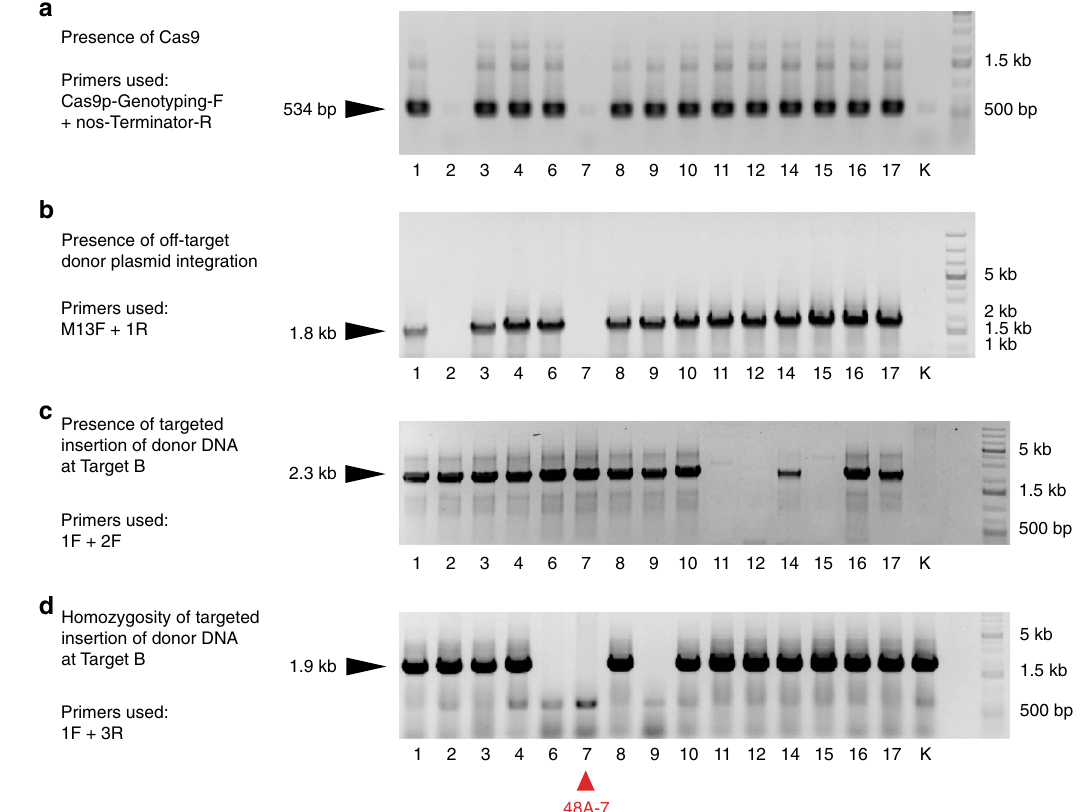
Fig. 3 Genetic segregation of the progeny of T0-48A. Genotyping the T1 progeny of T0-48A. The purpose of each PCR experiment and the genotyping primers used are shown to the left for each gel panel. a Primers Cas9p-Genotyping-F and nos-Terminator-R amplify a 534 bp DNA fragment in plants with the Cas9 module. b Primers M13F and 1R amplify a 1.8 kb DNA fragment in plants with the off-target insertion of the pAcc-B donor plasmid. c Primers 1F and 2F amplify a 2.3 kb DNA fragment in plants with the carotenoid cassette inserted at Target B. d Primers 1F and 3R amplify a 1.9 kb genomic DNA fragment in plants unless the carotenoid cassette at Target B is homozygous. The positions of the primers used are illustrated in Figs. 1a, b, 2a. Kitaake (K) was used as the negative control. The red triangle at the bottom marks 48A-7, which is free of the co-integrated CRISPR and donor plasmids. Source data are provided as a Source Data fi